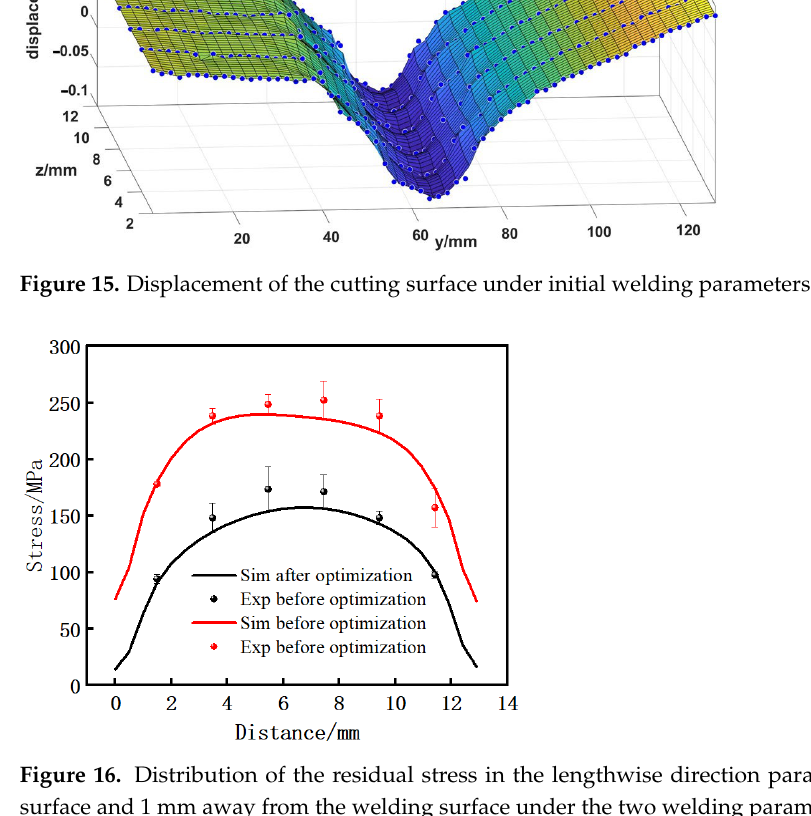
Figure 16. Distribution of the residual stress in the lengthwise direction parallel to the welding sur- face and 1 mm away from the welding surface under the two welding parameters.